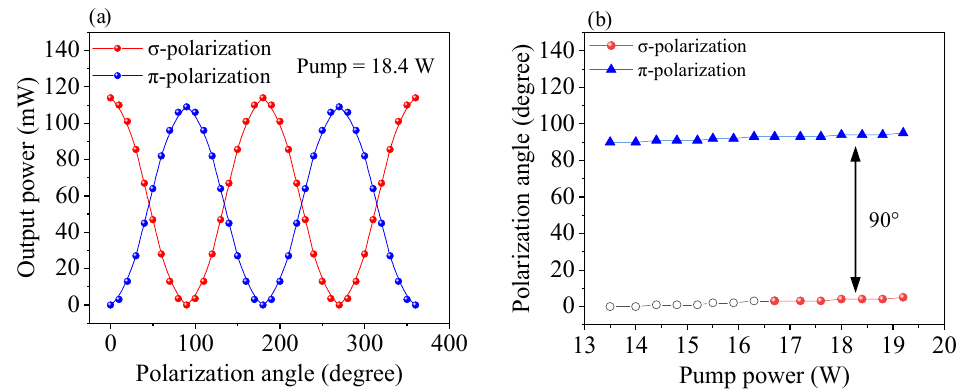
Figure 6. ( a ) The relationship between the angle of polarization and the output power; ( b ) polarization angles of the orthogonally polarized laser as a function of the pump power.